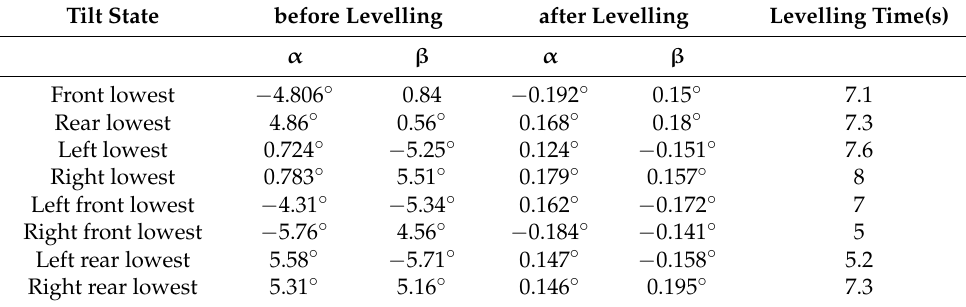
Table 2. Results of the levelling